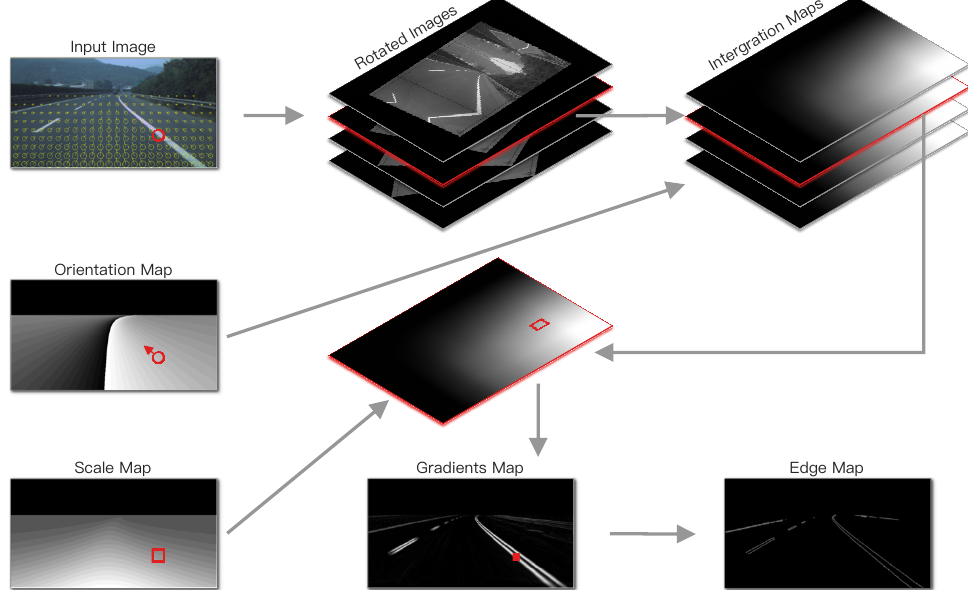
Figure 8. Workflow of the proposed speedup orientation and scale tuned difference of boxes (osDoB). With the orientation map and the scale map, we can steer the local edge extractor for the lane markings to the expected orientation and scale at every location in the frame